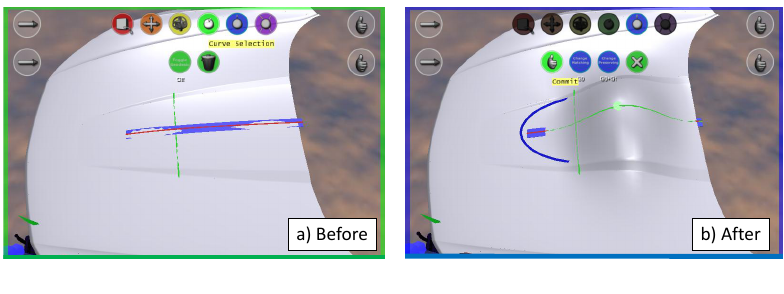
Figure 14. Local modification performed on a car